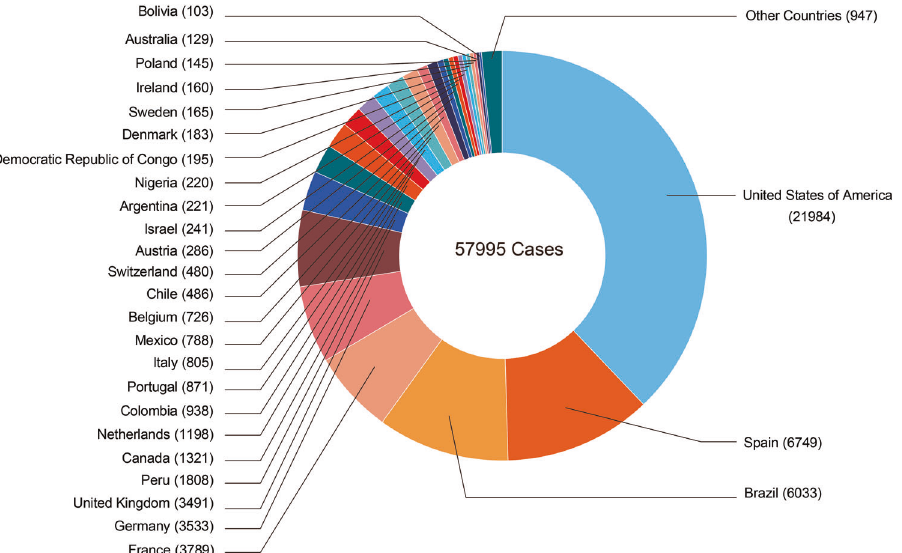
Fig. 1 Geographical distribution of con fi rmed monkeypox cases during the outbreak between January and September 2022. Con fi rmed cases include those laboratory-con fi rmed as monkeypox virus and may include cases only con fi rmed as orthopoxvirus. Data presented as of 12 September 2022 were obtained from CDC. Diagram generated with GraphPad Prism